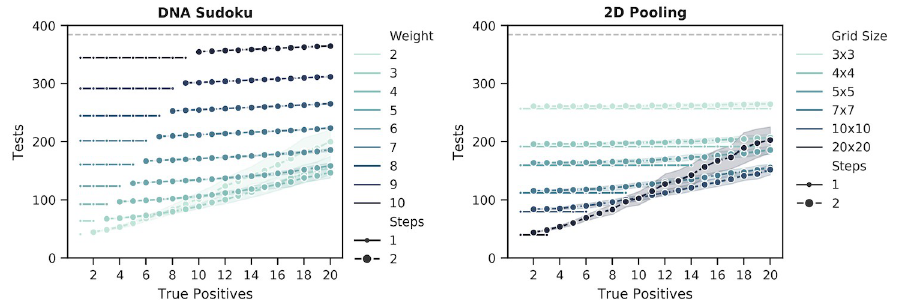
Fig 12. Changes in the number of tests and steps given different estimated positive rates for the non-adaptive methods. The figure shows the number of tests (y-axis) and the number of steps (marker size) required to recover all positive samples (x-axis) in simulations with N = 384 samples using DNA Sudoku and 2D Pooling methods. Each point is the average number of tests required for 100 simulations and the width of the bands is the standard deviation. The simulations were run using different weights for DNA Sudoku and different symmetrical 2D grid sizes for 2D Pooling. Small markers indicate unambiguous results that required only a single round of testing and the larger markers indicate ambiguous results that required a second validation step to correctly identify the positive samples. The grey dashed line is the number of tests required for individual testing.